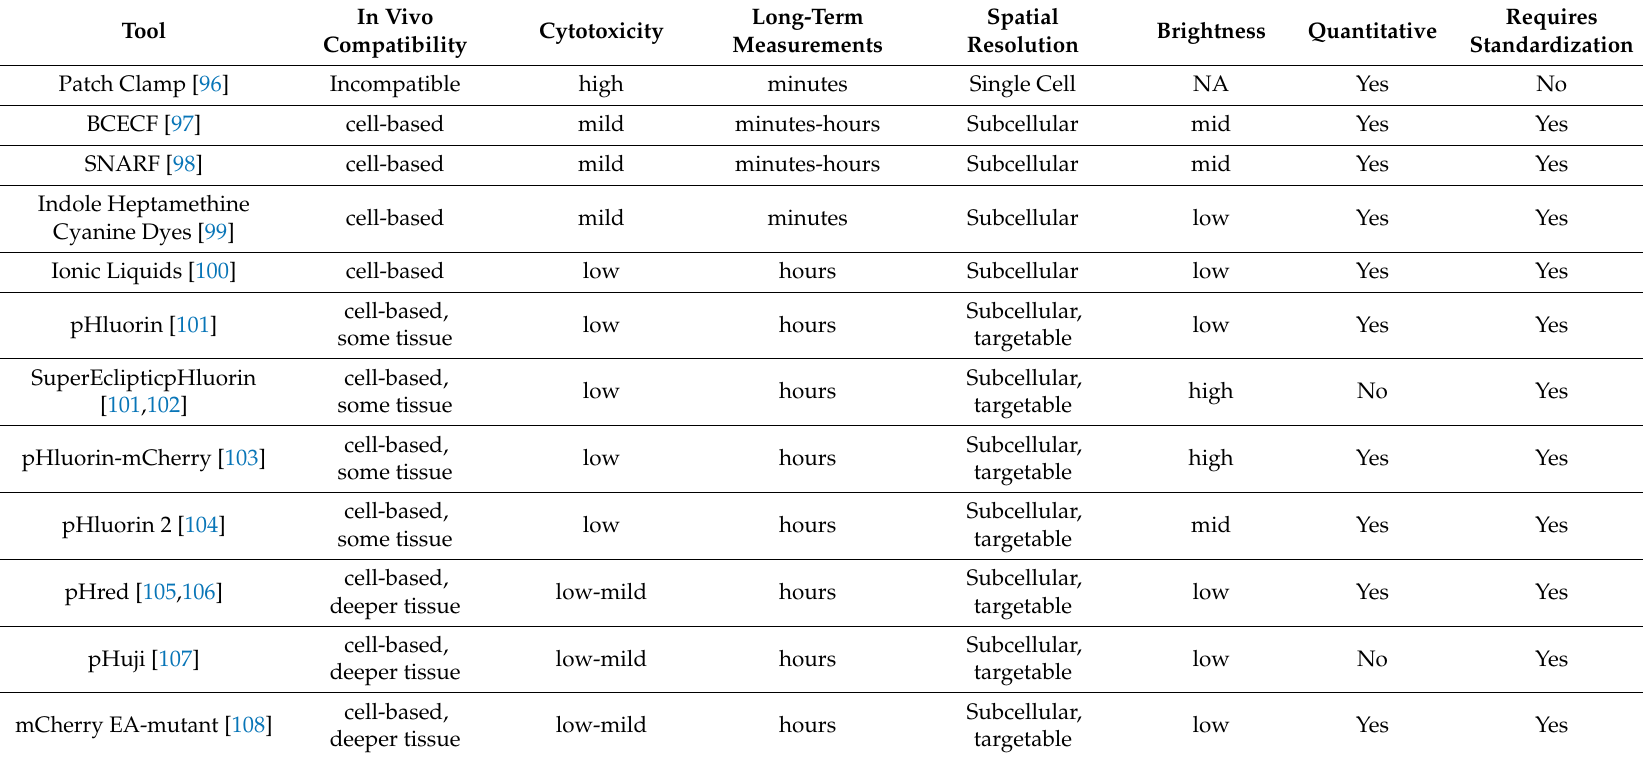
Table 1. Comparison of Tools for Measuring Intracellular